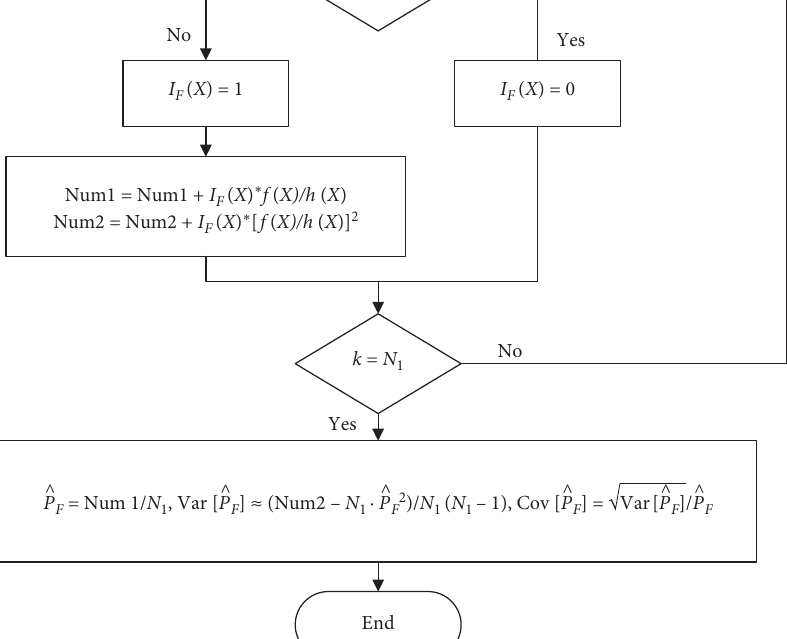
Figure 3: The flowchart of reliability analysis of the drum brake based on the ANN-IS